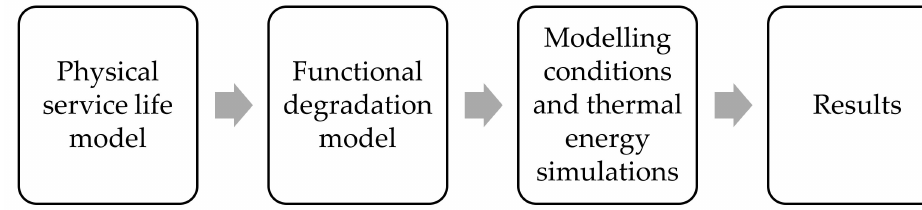
Figure 1. Research methodological